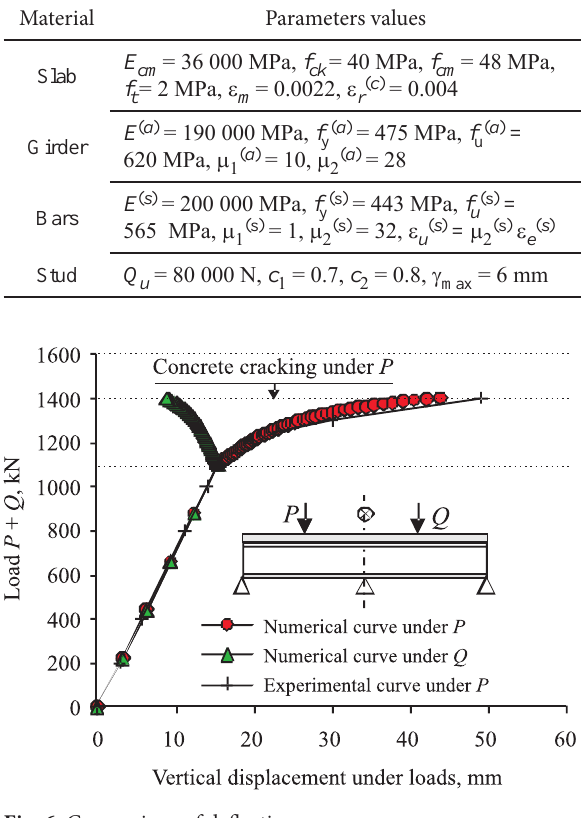
Fig. 6. Comparison of deflections